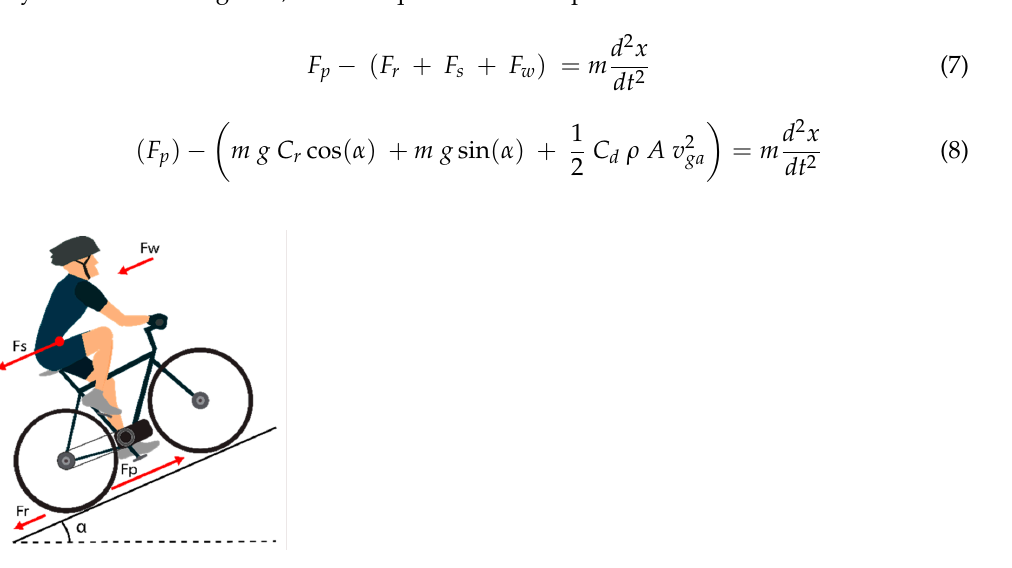
Figure 3. Dynamic diagram of an electric